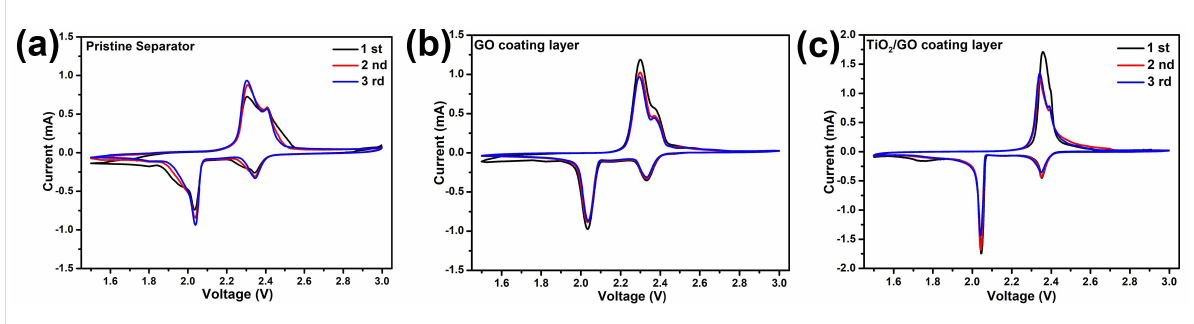
Figure 5: CV curves of the Li/S batteries with a (a) pristine separator, (b) GO-coated separator and (c) TiO 2 /GO-coated separator.